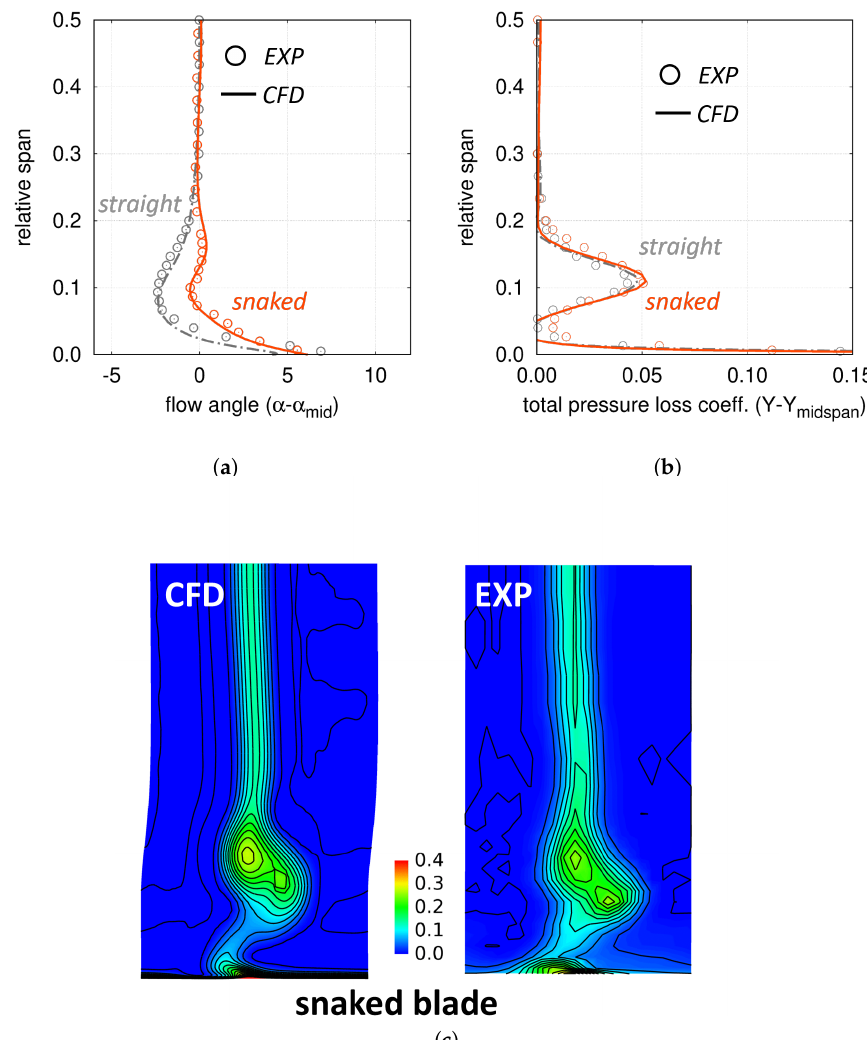
Figure 14. Comparison between numerical and experimental results: ( a ) pitch-wise averaged swirl angle distribution; ( b ) pitch-wise averaged total pressure loss coefficient ; ( c ) 2D contour-plots of total pressure losses downstream of the snaked